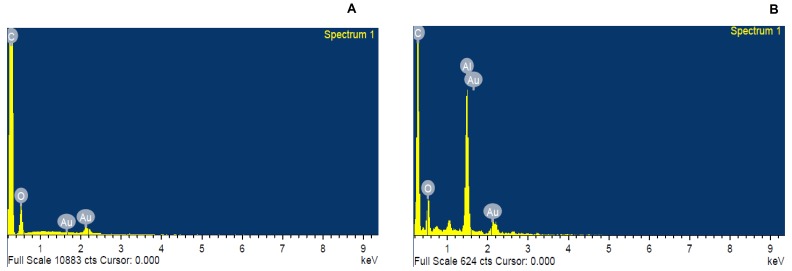
SEM-EDS spectrum of glucose-capped gold nanoparticles and 2DG-capped gold nanoparticles.SEM-EDS analysis of (A) glucose-capped gold nanoparticles; (B) 2DG-capped gold nanoparticles;